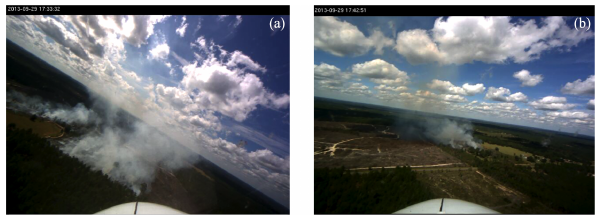
Figure 1. NASA P-3B front camera frames showing the for- est understory fire and the emanating biomass burning plume at 17:33:32 (a) and 17:42:51UTC (b) .